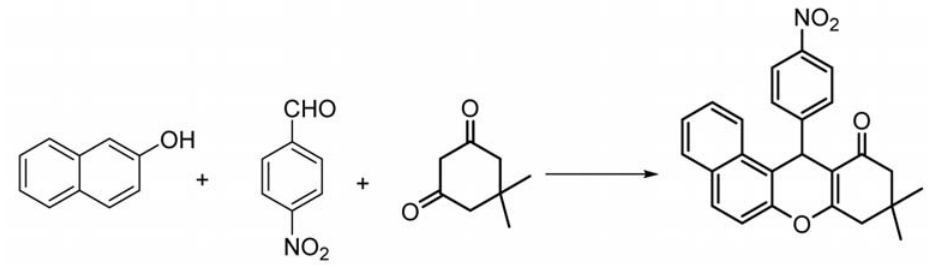
Table 2. The model study for the synthesis of xanthene 4h by vari- @ SiO O 3 4 2 ous catalysts. a Entry Catalyst